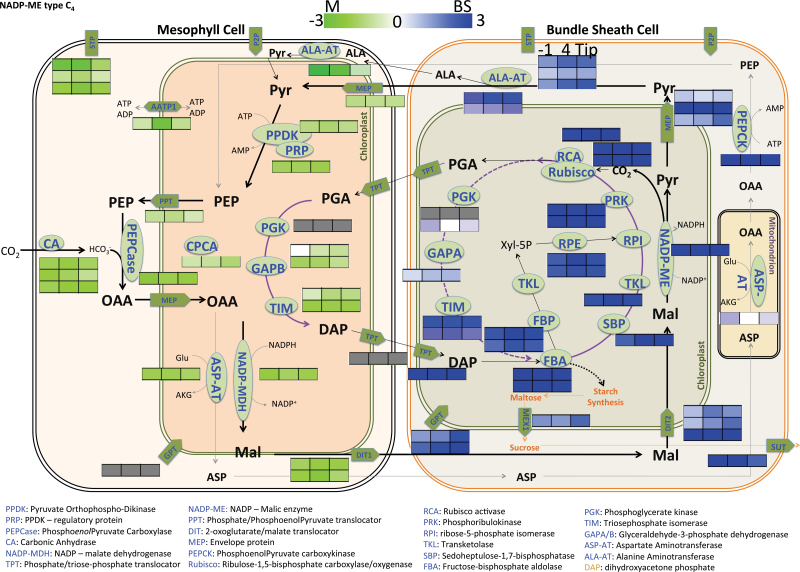
C4 cycle genes required for cell cooperation are cell-biased at SST. The C4 cycle between BS and M cells relies on numerous enzymes expressed in either cell type. Heat maps of three boxes next to enzyme names represent the log2-transformed BS/M expression ratio at the three developmental stages sampled (SST, maturing, mature). Each row indicates the results from a gene with the same proposed activity. Green signifies an M-biased ratio and blue represents a BS-biased ratio. Modified from Li et al., 2010 and detailed expression data is found in Supplementary dataset 2.